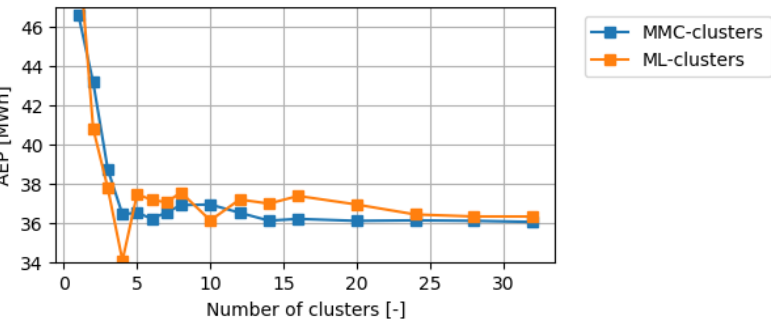
Figure 21. Comparison of the AEP convergence with increasing number of clusters at the onshore reference location for the MMC and ML cluster wind resource